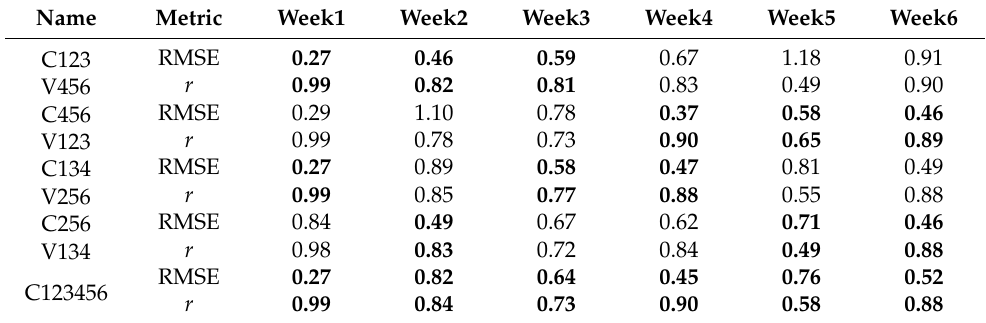
Figure 6. Parameter selecting based on GB models that were calibrated using one week (C1V5). Coloured bars indicate parameters selected for each calibration set, dashed line indicates mean value. Table 5. Accuracy of models calibrated using three weeks of data. The values in bold indicate the accuracy of the calibration